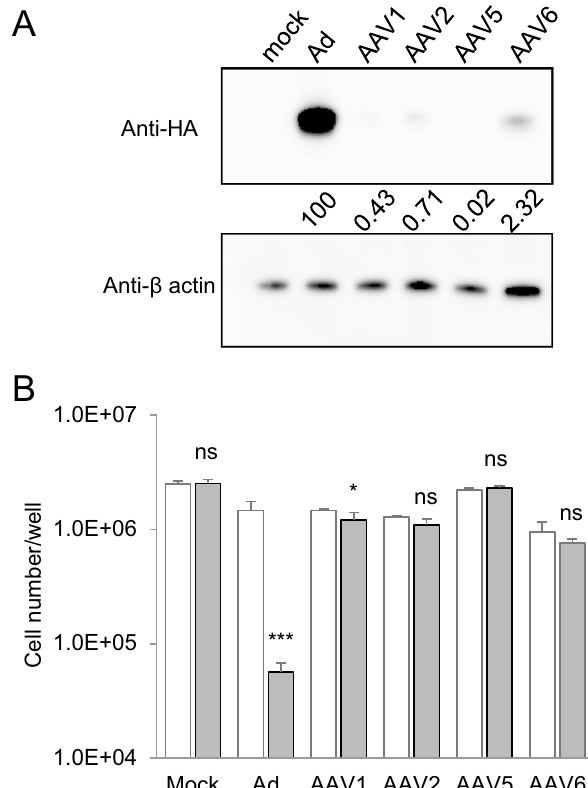
Figure 1. Selection of viral vectors for the transduction of NPCs. ( A ) The expression of iCasp9 with a C terminal HA-tag in lysates of immortalized NPCs transduced with the Ad vector (3 pfu/cell) and the AAV1/2/5/6 vectors (670 vg/cell) was assessed by western blotting with an antibody against the HA-tag. β-actin expression levels were assessed in parallel for normalization. The relative iCasp9 expression obtained from the band intensity of iCasp9 divided by that of β-actin is shown. Full-length blots are shown in Supplementary Fig S1. ( B ) The number of cells transduced with viral vectors was counted after treatment with or without AP1903 (open column, without AP1903; filled column, with AP1903). Data are presented as means ± standard deviation (SD) (n = 3, biological replicates). The statistical significance of differences between cells treated with and without AP1903 was determined by two-way ANOVA and SNK post-hoc test ( * P < 0.05; *** P < 0.005; ns, not significant vs. without AP1903, SigmaPlot Version